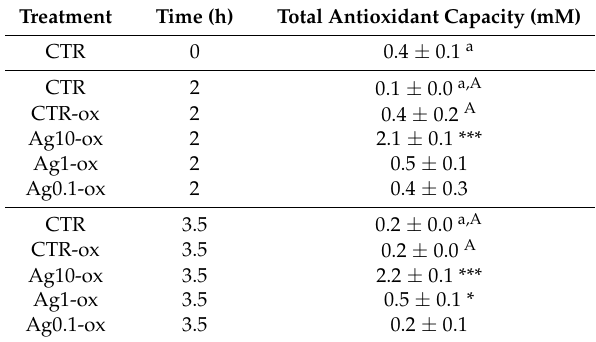
Table 1. Total antioxidant capacity of boar sperm samples submitted to oxidative stress (CTR except) and supplemented with